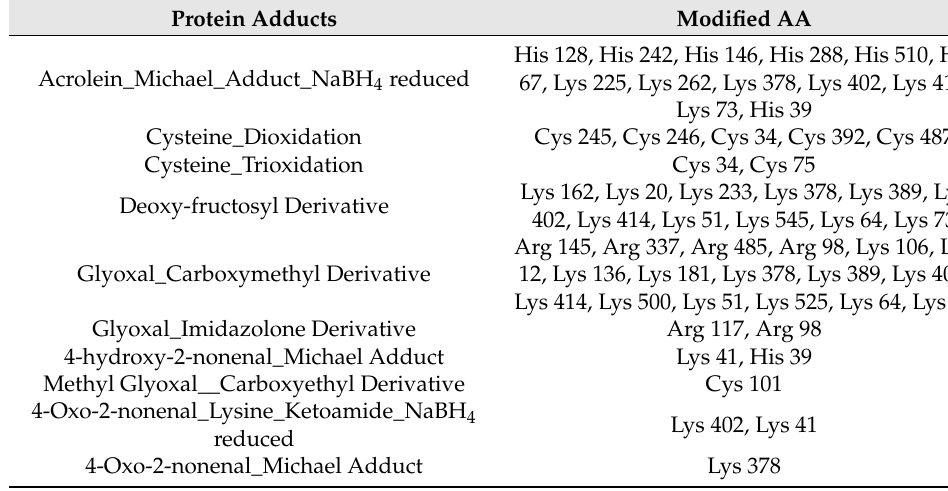
Figure 2. Fragmentation spectra related to a carboxymethyl-Lys adduct (CM-Lys 12) identified through the computational analysis (Proteome Discoverer) and confirmed by manual check.